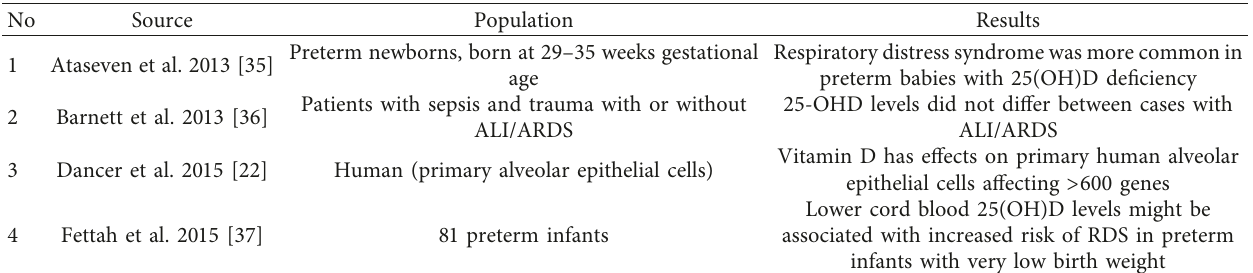
Table 3: Reports of the correlation between vitamin D deficiency and respiratory distress syndrome in human